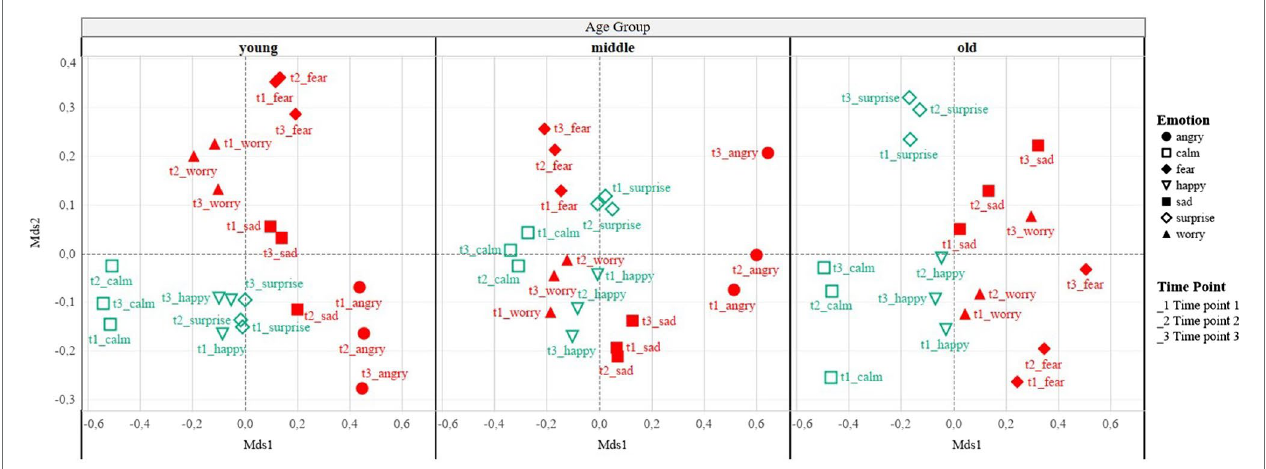
FIGURE 6 | Visualisation of non-metric multidimensional scaling analysis for each age group, where each positive emotion at each time point is shown in green and the negative emotions at each time point is shown in red (representation created using the software